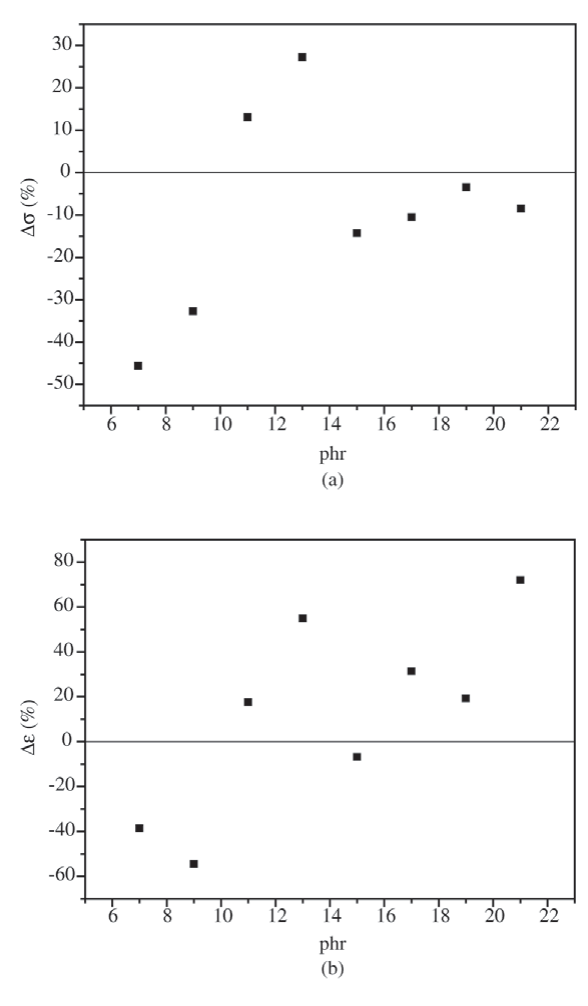
Figure 2. Percent variation of the tensile mechanical properties between the as fabricated epoxy formulations and the aged formu- lations. a) Tensile strength; b) Strain at